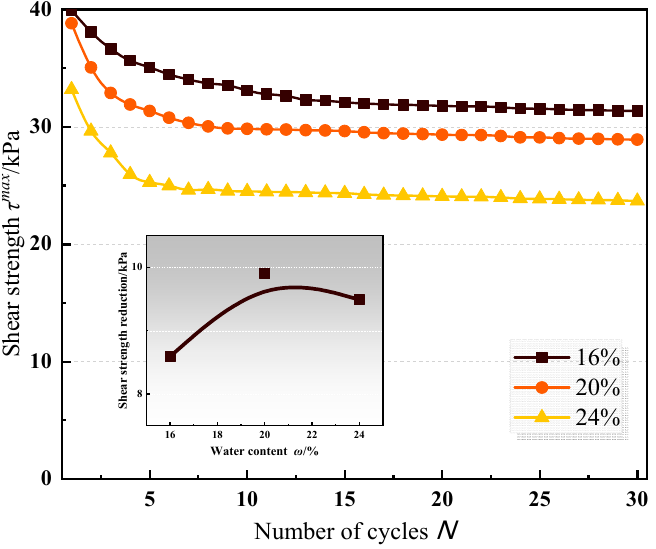
Figure 14. Shear strength–number of cycles curve under different water content levels.